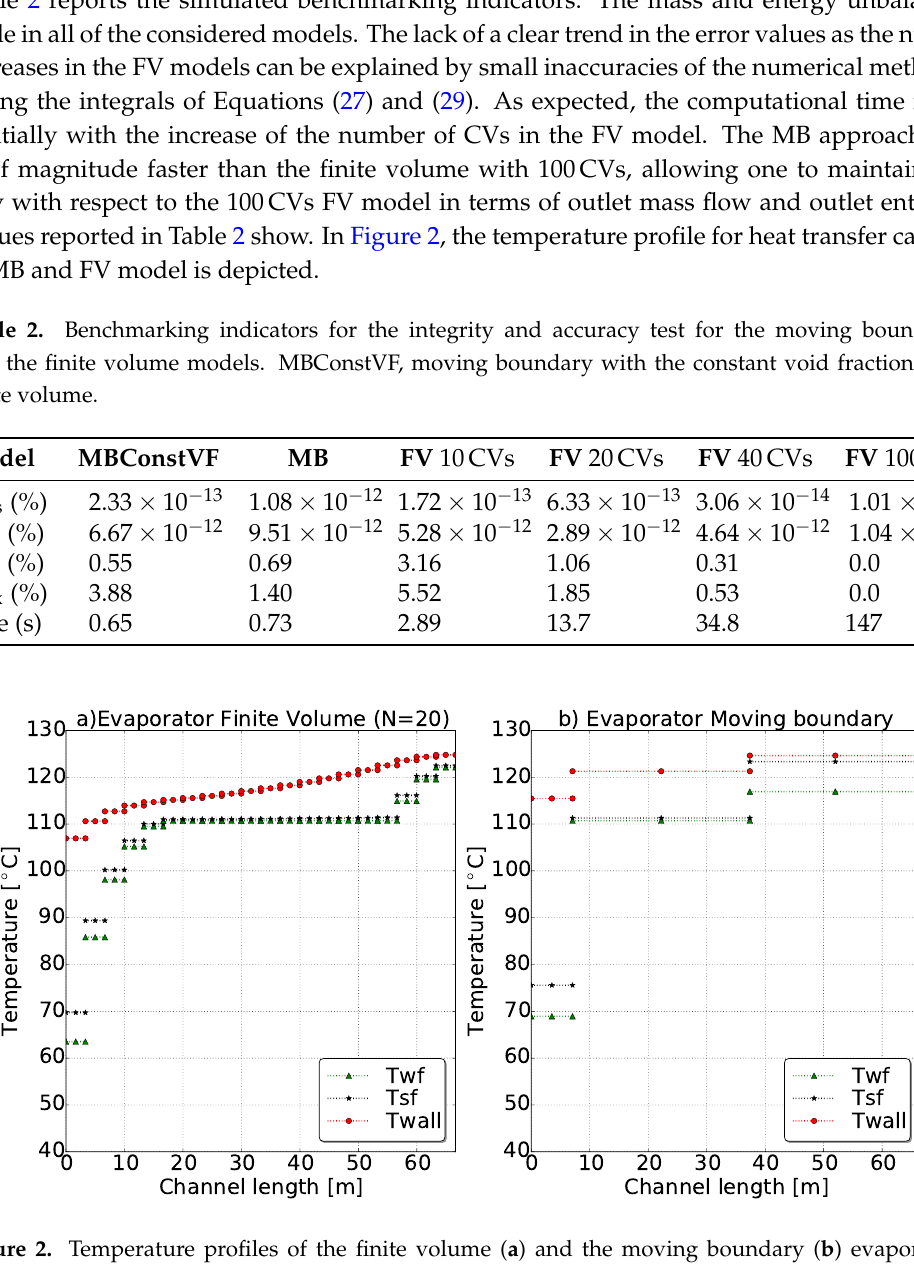
Figure 2. Temperature profiles of the finite volume ( a ) and the moving boundary ( b ) evaporator models as they are assumed by the application of Newton’s law of cooling to solve the heat transfer problem. Each segment corresponds to one control